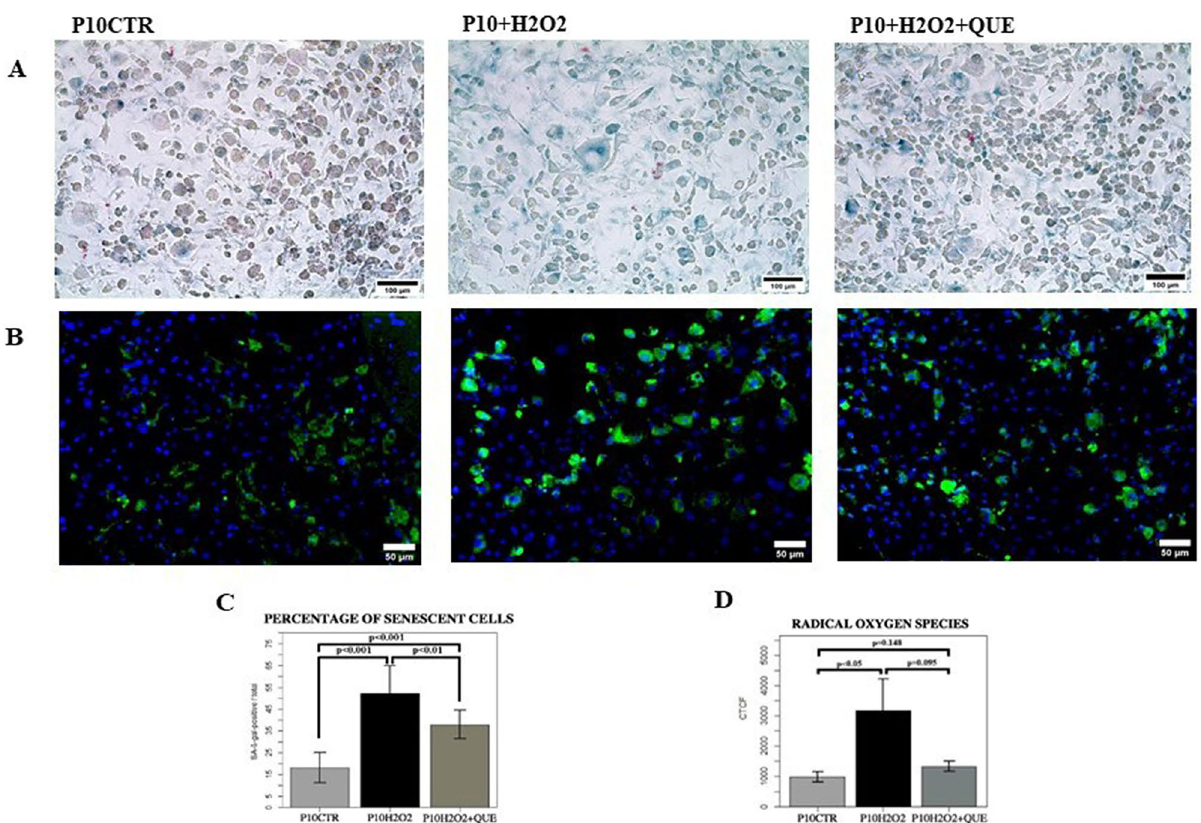
Figure 3. ( A ) Evaluation of the adipocyte’s senescence with the specific staining for β-galactosidase. Representative images of cell senescence in adipocytes at PID10 (P10CTR), adipocytes stimulated with H 2 O 2 (P10H2O2) and treated with H 2 O 2 plus quercetin (P10H2O2 + QUE). Scale = 100 μm. ( B ) Significant images of the accumulation of intracellular ROS (in green) in 3T3-L1 fat cells at PID10 (P10CTR), PID10 treated with H 2 O 2 (P10H2O2) and PID10 treated with H 2 O 2 plus quercetin (P10H2O2 + QUE). Scale = 50 μm. ( C ) Histograms showing the percentage of senescent cells among adipocytes (P10CTR), adipocytes treated with H 2 O 2 and adipocytes treated with H 2 O 2 plus quercetin (P10H2O2 + QUE), at the 10th day after induction. The values are represented as mean ± SE. ( D ) Histograms showing the amount of ROS among adipocytes (P10CTR), adipocytes treated with H 2 O 2 (P10H2O2) and PID10 treated with H 2 O 2 plus quercetin (P10H2O2 + QUE), at the 10th day after induction. The values are represented as mean ±